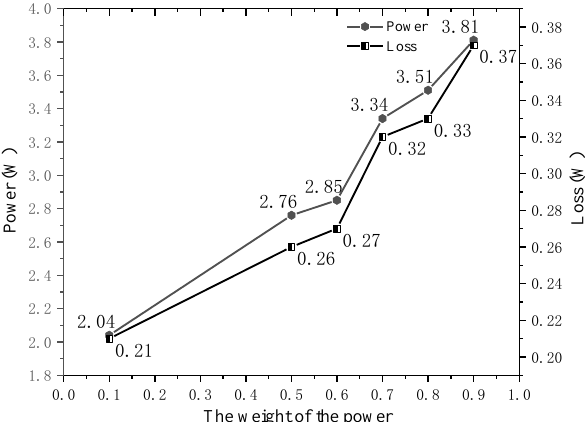
Figure 8. Loss optimization.